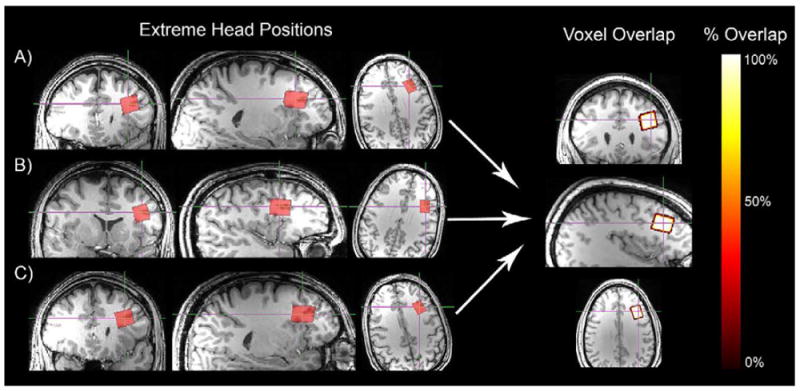
Left panel: Orthonormal slices of the three extreme head positions
evaluated during the ‘proof-of-principle’ investigation are
depicted. Right panel: Using voxel parameter information from the
dicom file generated during 1H MRS acquisition, each voxel was
recreated in subject space, coregistered to template space, and 3D geometric
voxel overlap was evaluated. Note: white indicates complete voxel
overlap, yellow-orange gradient indicates incomplete voxel overlap, and red
indicates no voxel overlap.